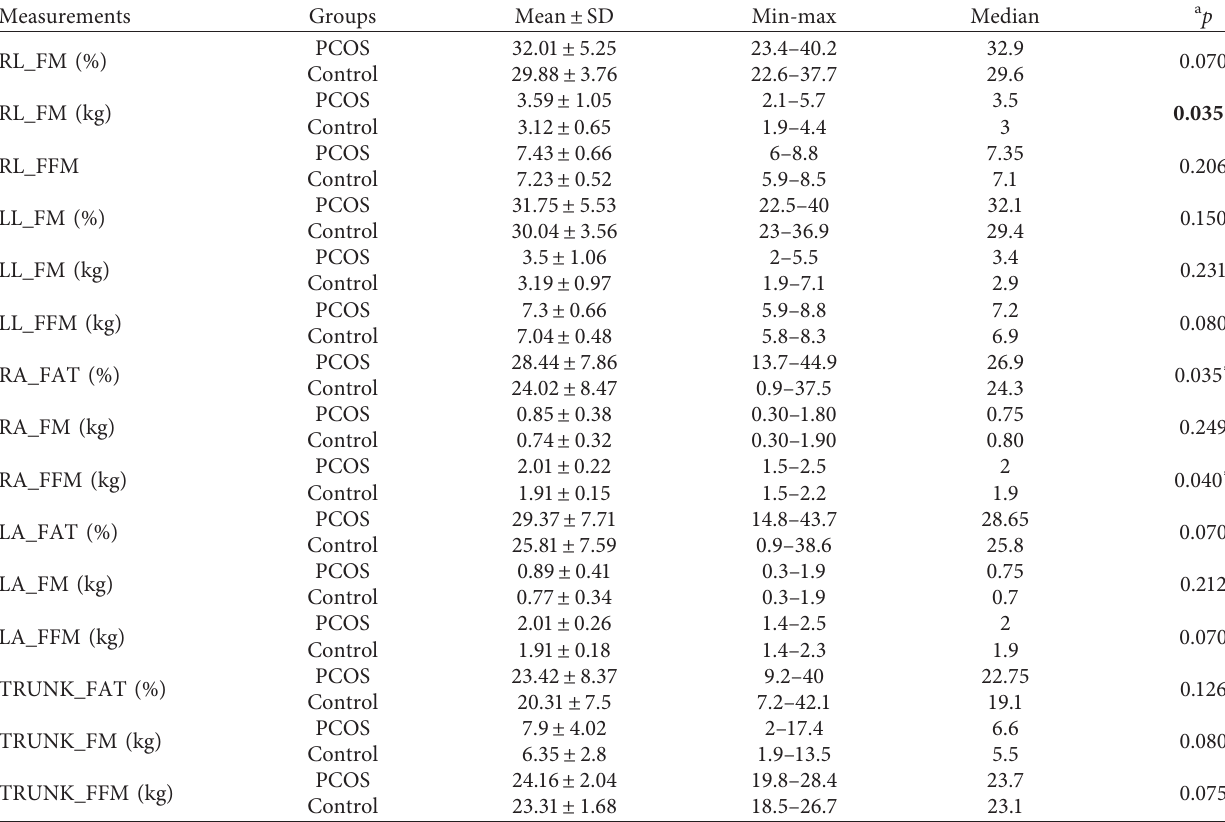
Table 3: Segmental body composition measurements.